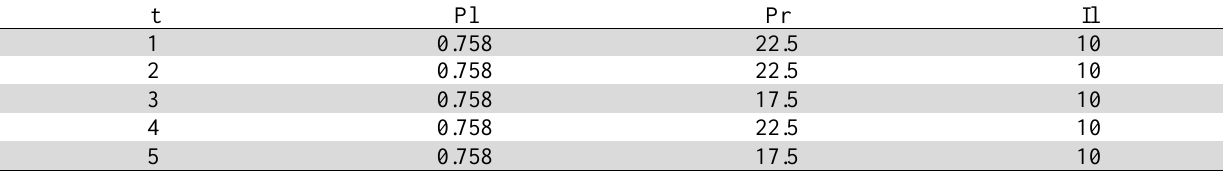
Solution results: examples for five